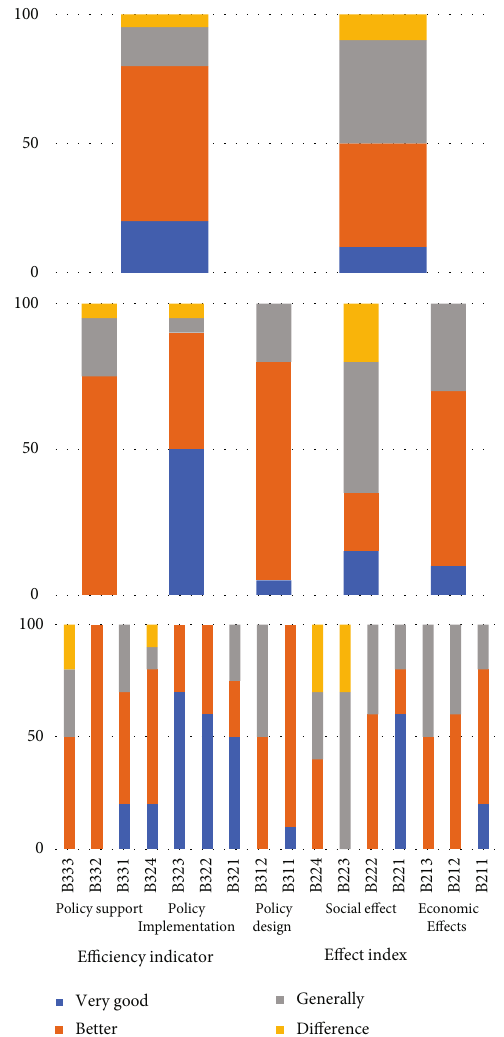
Figure 5: Teacher evaluation